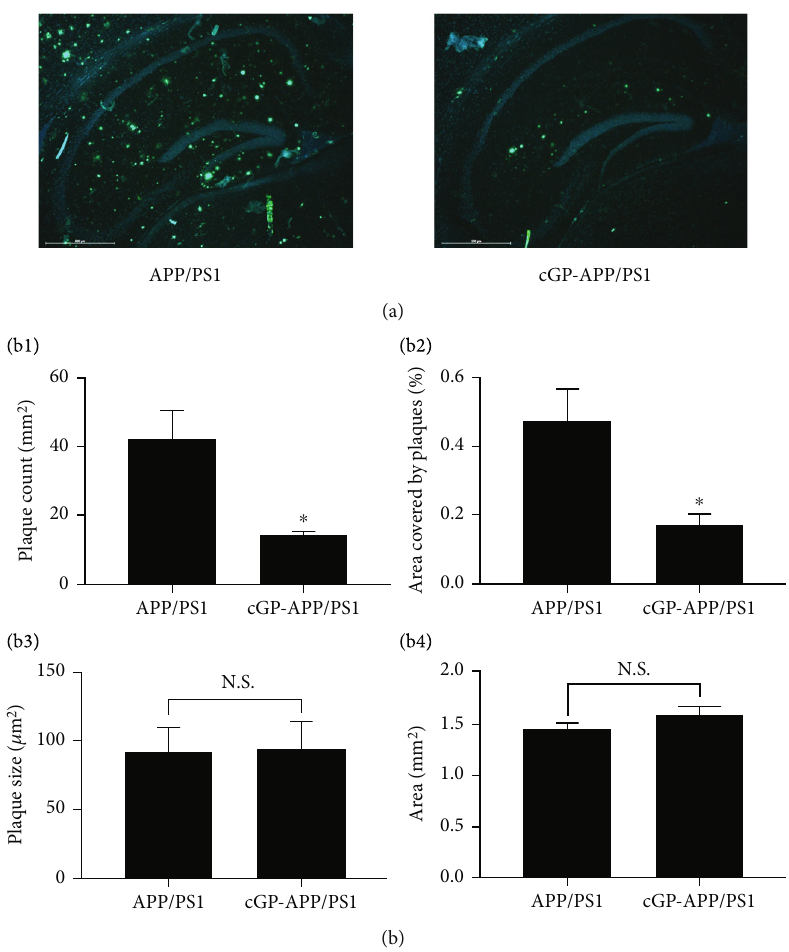
Figure 2: cGP treatment reduces amyloid plaque load in the hippocampus of APP/PS1 mice. Amyloid plaque load was evaluated in the hippocampus of APP/PS1 mice and cGP-treated APP/PS1 (cGP-APP/PS1) mice. Representative thio fl avin-S-stained hippocampal sections from both groups of mice are shown in (a) (scale bar, 500 μ m). Treatment with cGP reduced the plaque density (b1) and percentage area covered by plaques (b2) in cGP-APP/PS1 mice ( n = 4 in both groups). The average size of remaining plaques in cGP- APP/PS1 mice was similar to plaque size in APP/PS1 mice (b3), and total area used for plaque load analysis (b4) was similar in the two groups of mice. Asterisks denote signi fi cant di ff erence ( p < 0 : 05 ) compared to APP/PS1 group. N.S.: not signi fi